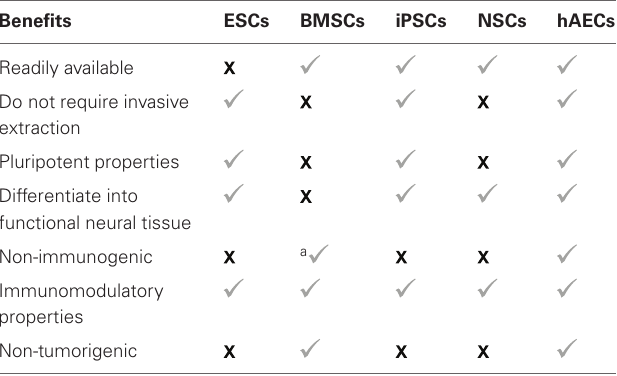
Table 1 | Beneficial characteristics of five major stem cell